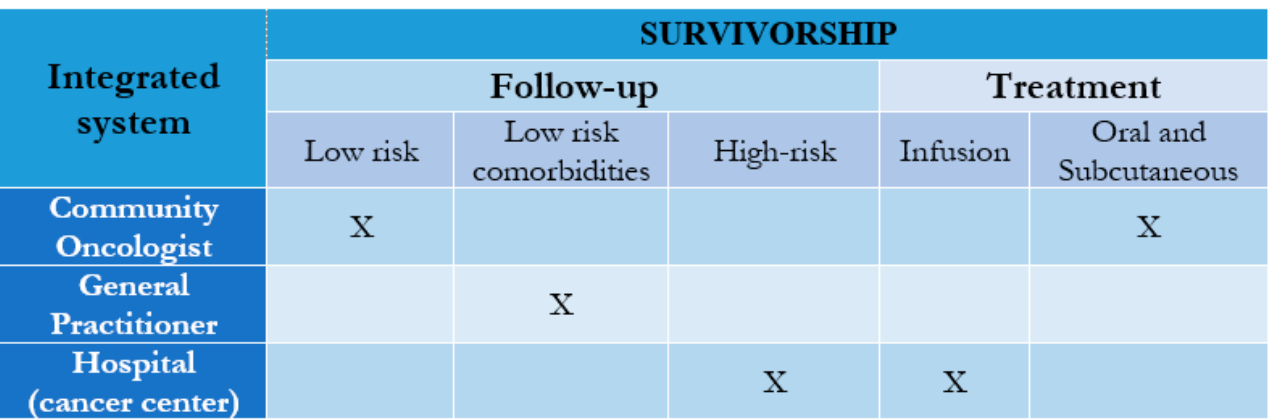
Figure 1. Model of interrelation between patients’ categories and integrated health care.